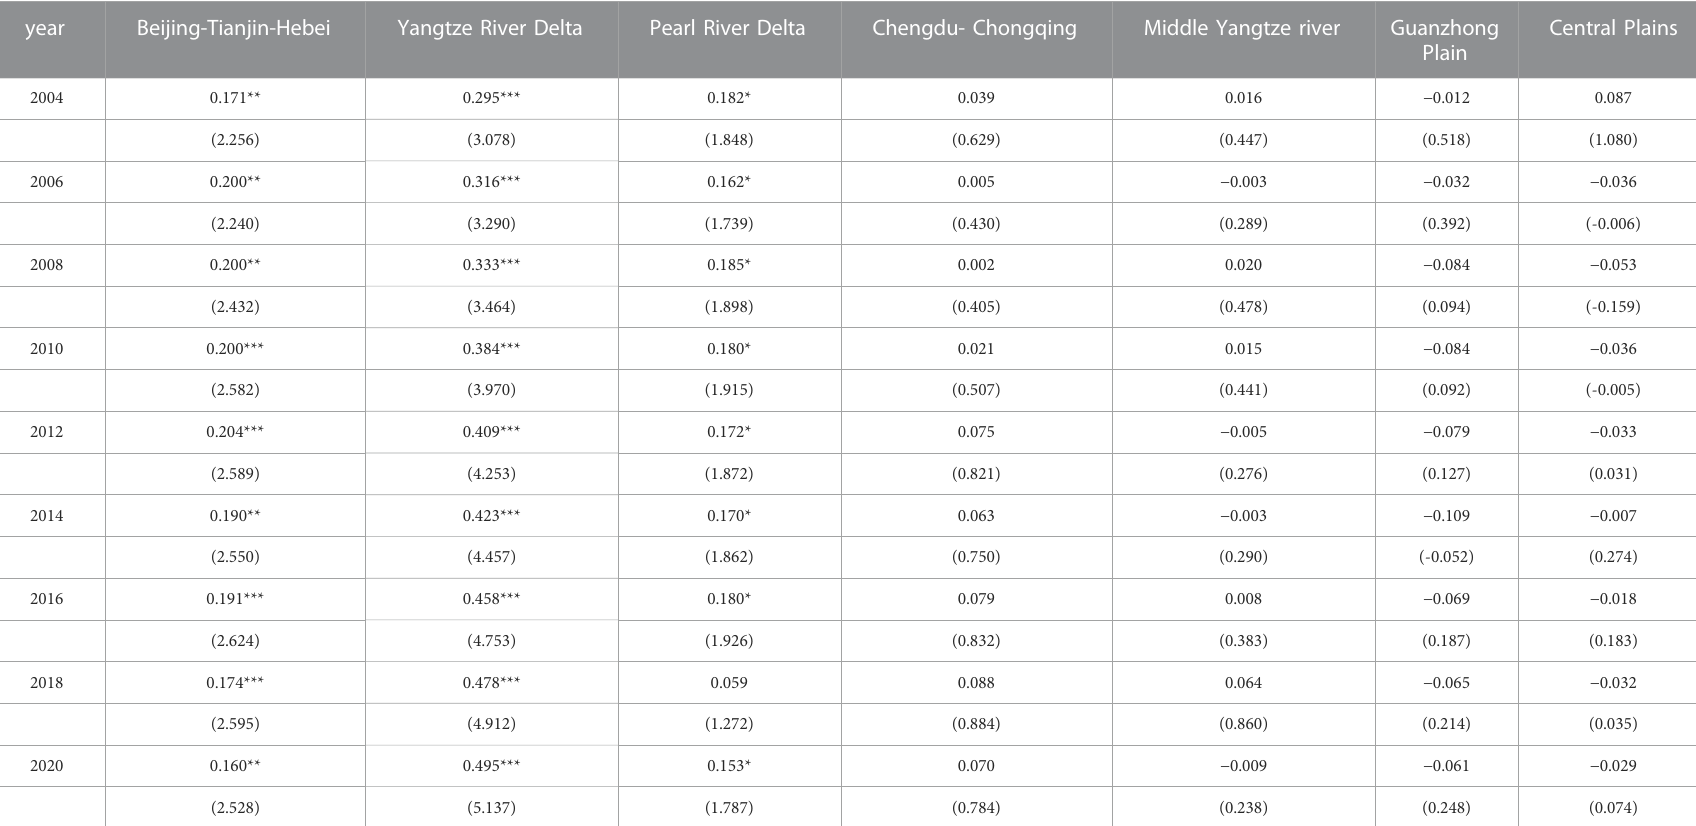
TABLE 9 The spatial relevance of the coupling coordination degree of science and technology fi nance and green development in China ’ s seven urban agglomerations.